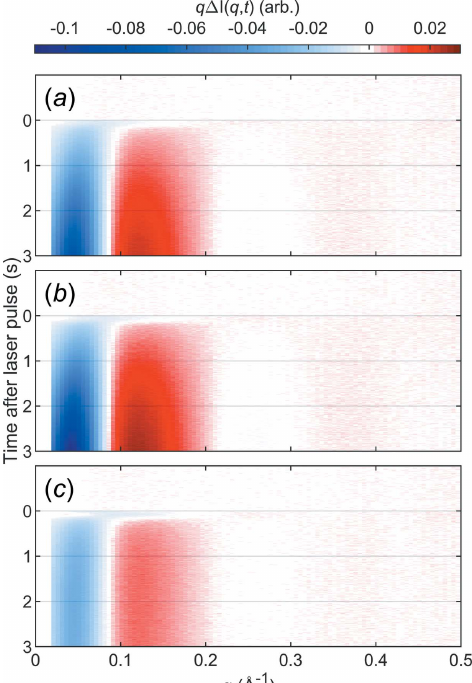
Figure 6 Data from a T-jump TR-XSS experiment on lysozyme. ( a ) Heat subtracted data in the SAXS range for a T-jump on lysozyme starting at 20 (cid:5) C. ( b ) Heat subtracted data in the SAXS range for a T-jump on lysozyme starting at 30 (cid:5) C. ( c ) Heat subtracted data in the SAXS range for a T-jump on lysozyme starting at 40 (cid:5)